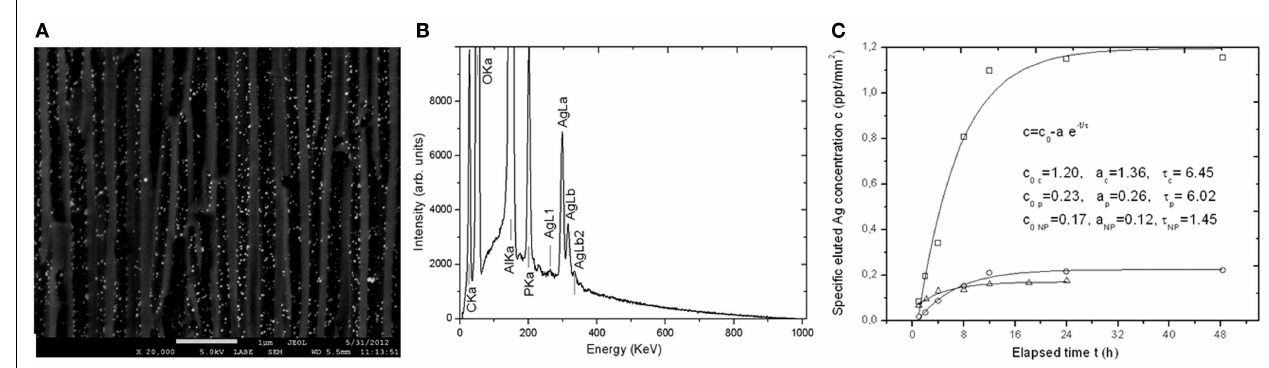
FIGURE 6 | (A) compositional SEM image (backscattered electrons) of the cross-section of an APA membrane as that used in the novel restorative composite ofThorat et al. (2014), showing high-atomic number nanoparticles dispersed in the pores. (B) SEM EDS spectra obtained from the same area as in (A) , displaying the silver of the nanoparticles in (A) . (C) Plots of elution of silver from loaded APA membranes as in (A,B) . Reprinted fromThorat et al. (2013b).